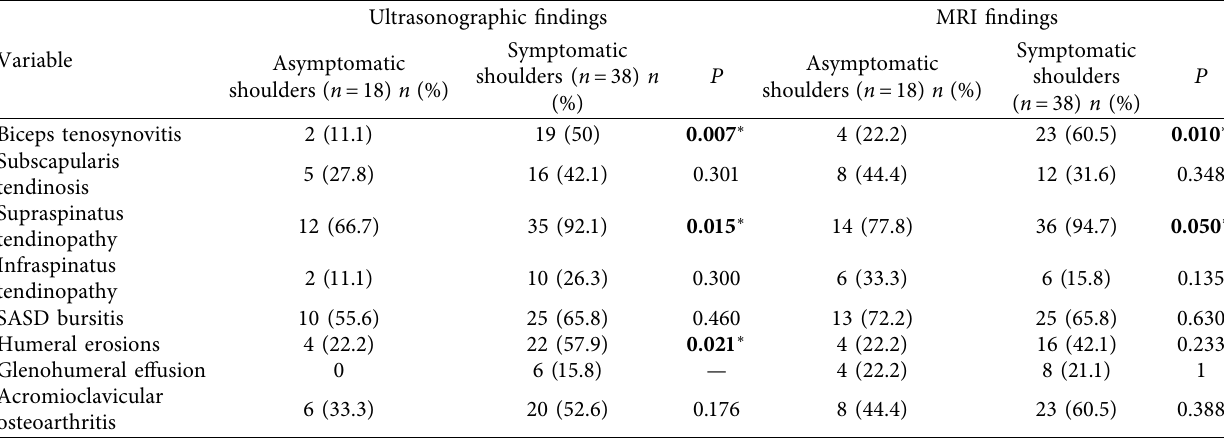
Data were expressed in mean ± SD, n (%) or median (min-max). Table 2: Ultrasonographic and MRI findings in asymptomatic ( n � 18) and symptomatic shoulders ( n � 38) in the study HD